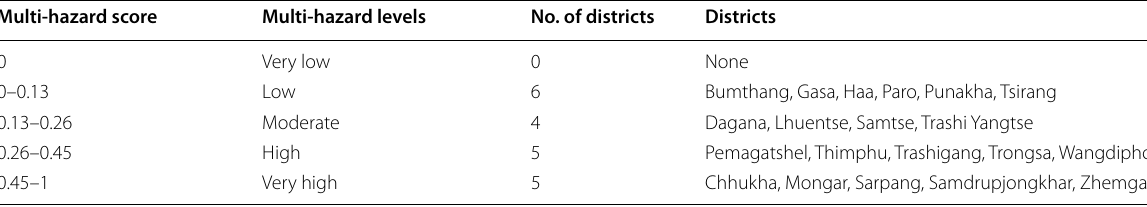
Table 9 Summary of multi-hazard levels Multi-hazard